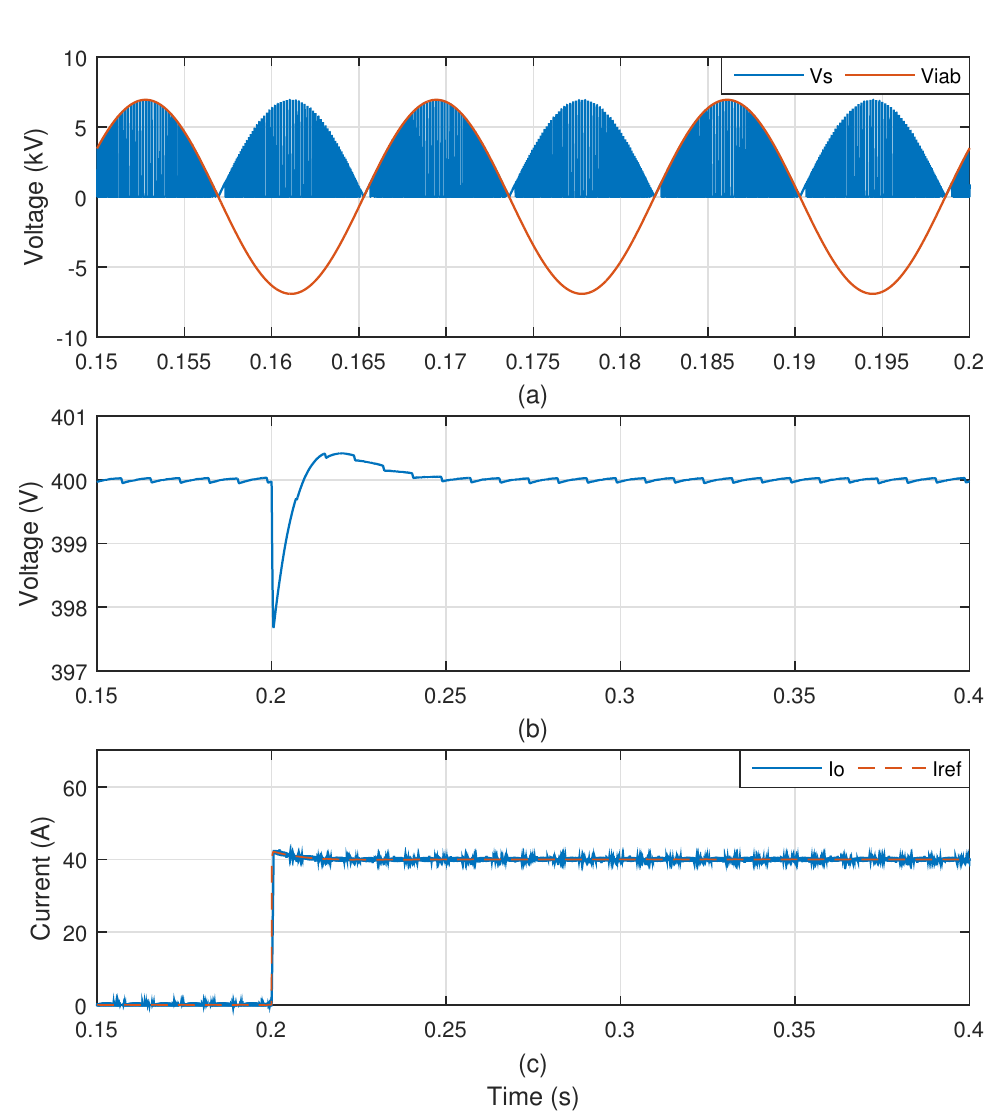
Figure 19. AC-DC 2 × 2 DMC operation. ( a ) Output switched voltage along with input voltage, ( b ) output voltage, and ( c ) output